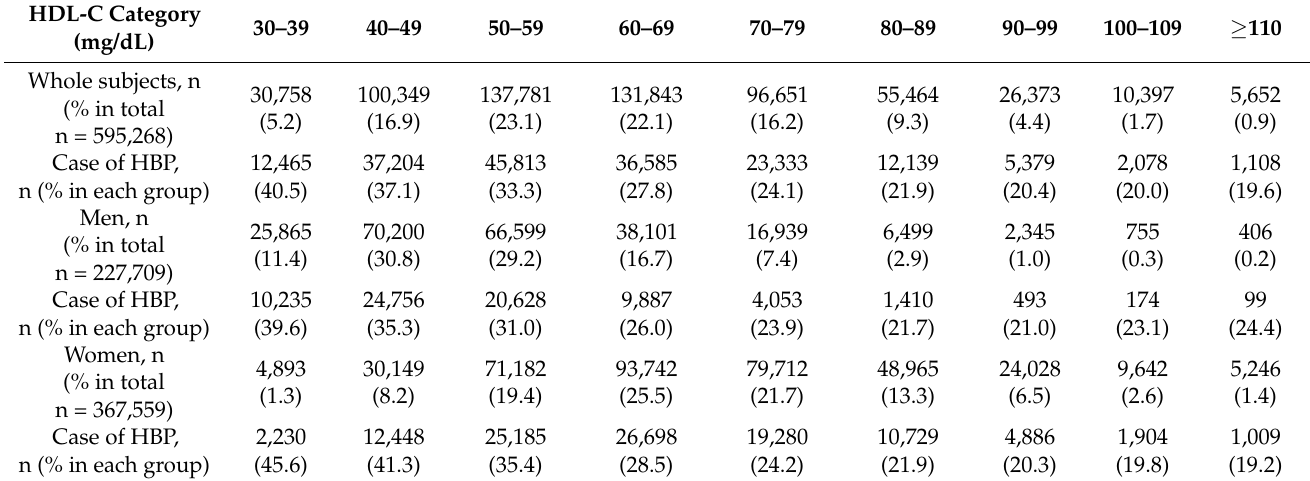
Table 3. Prevalence of HBP according to nine HDL-C concentration categories in subjects who hardly consumed alcohol. HDL-C category